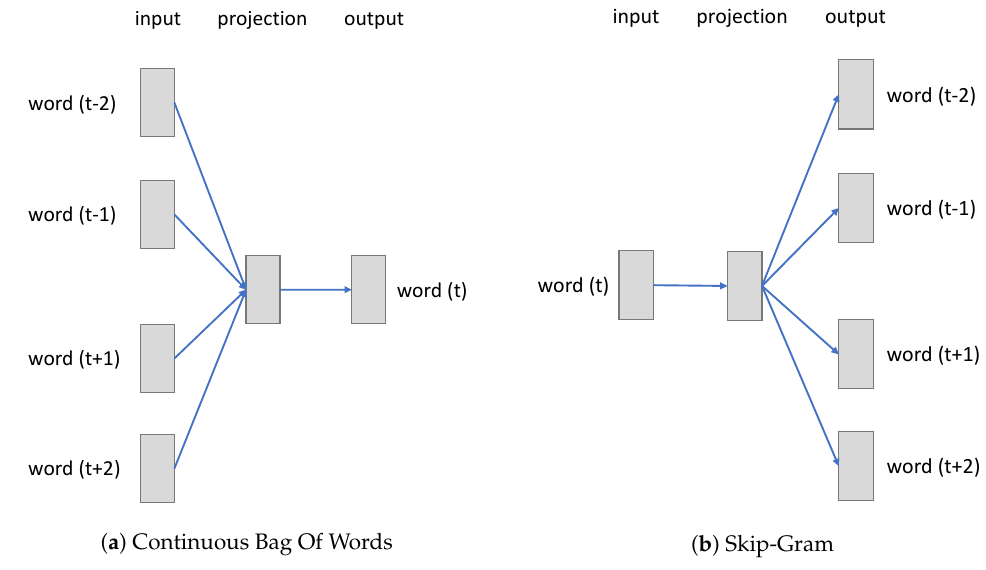
Figure 1. Word2Vec